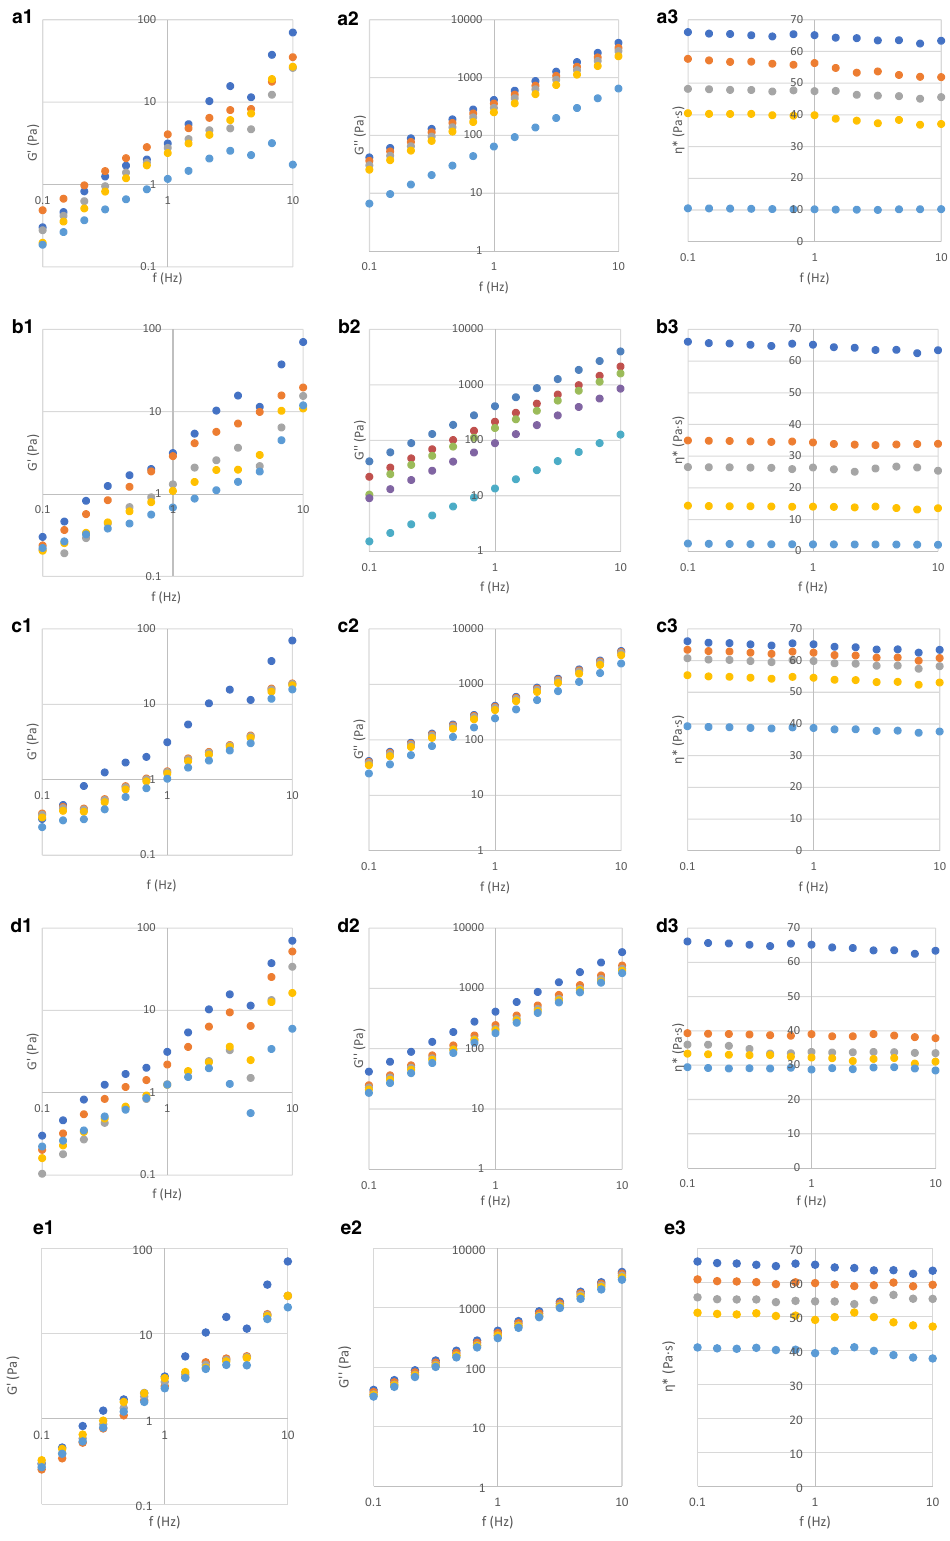
Figure 2. Dynamic rheological behaviour of honey (1—elastic modulus, 2—loss modulus, 3—complex viscosity) adulterated with: ( a ) agave syrup, ( b ) maple syrup, ( c ) inverted sugar, ( d ) corn syrup, ( e ) rice syrup. Dark blue dot: authentic; orange dot: 5% adulteration; grey dot: 10% adulteration; yellow dot: 20% adulteration; light blue dot: 50%